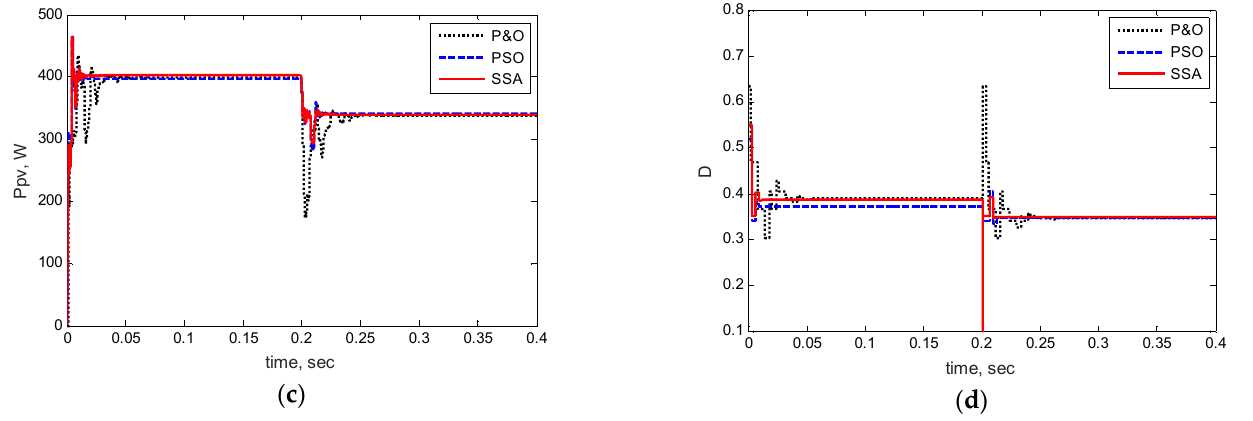
Figure 10. Photovoltaic panel tracking curves using P&O, PSO and SSA methods in the condition of shade pattern 1: ( a ) Vpv, ( b ) Ipv, ( c ) Ppv, ( d ) duty cycle. shade pattern 1: ( a ) Vpv, ( b ) Ipv, ( c ) Ppv, ( d ) duty cycle.